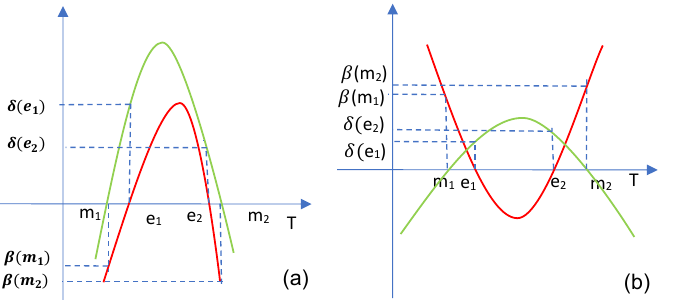
Figure 4. Graphical representation of ∆ 1,2 . Case IV ( m 1 < e 1 < e 2 < m 2 ): ( a ) a < 0, h < 0; ( b ) a > 0, h <